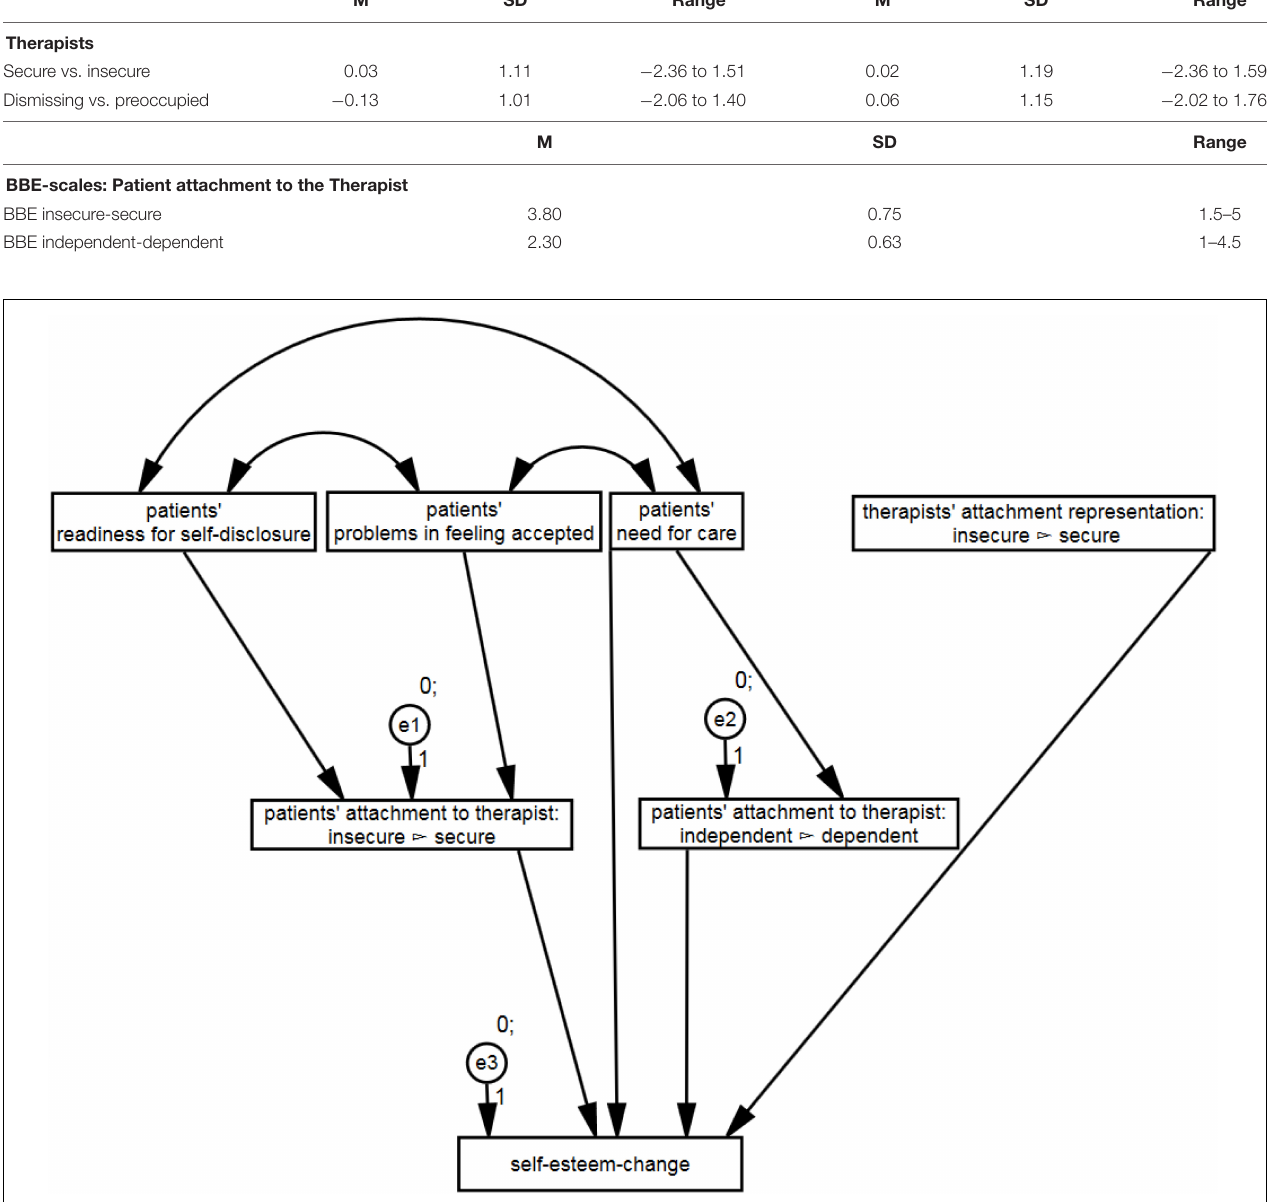
TABLE 2 | Distribution of Adult Attachment Interview scales of therapists ( N = 16) and distribution of the Relationship-specific attachment scales (BBE) of the patients ( N = 573). AAI-scale Raw Standardized M SD Range M SD Range